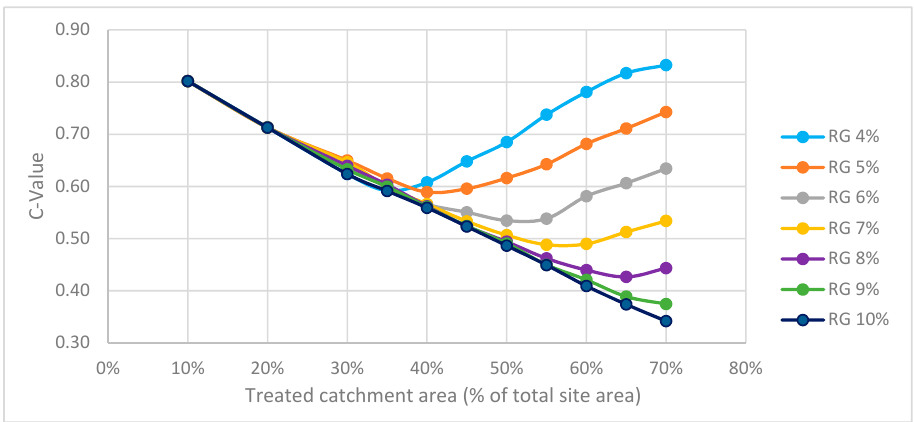
Figure A4. Residential precinct results of effective C-value versus treated catchment area for various rain garden sizes. Table A8. Residential precinct results of optimum treated areas and C-values for various rain garden sizes. Rain Garden Area (% of Total Site Area)